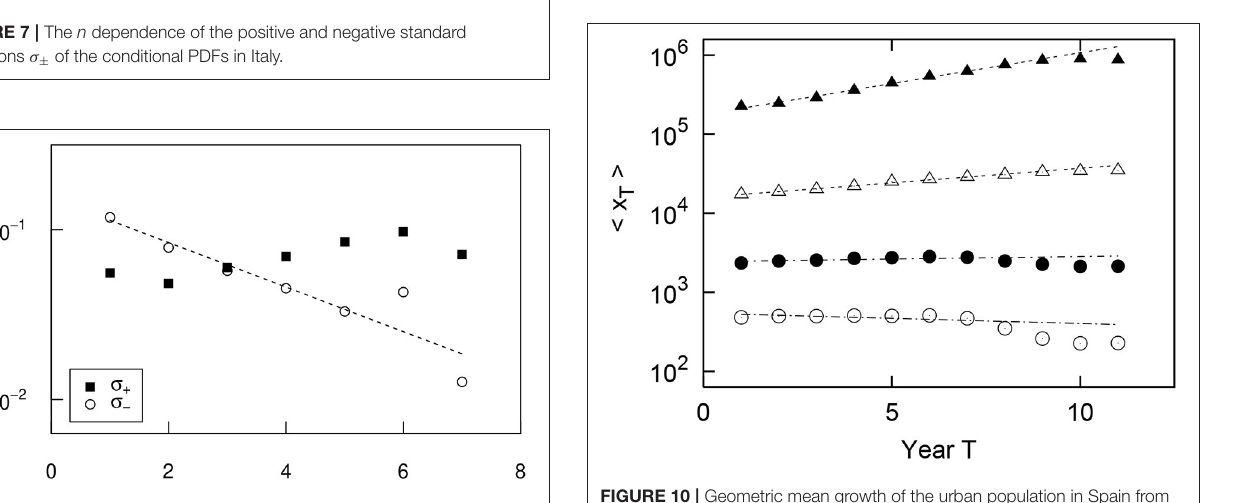
FIGURE 10 | Geometric mean growth of the urban population in Spain from 1900 to 2001 ( T = 1,2, ··· ,11). The original population of x 1 in 1900 ( T = 1) is divided into logarithmically equally sized bins: x 1 ∈ [10 m + 1 ,10 m + 2 ) ( m = 1,2,3), x 1 ≥ 10 5 ( m = 4). In the figure, ◦ , • , △ , and N each represent m = 1,2,3, and 4,